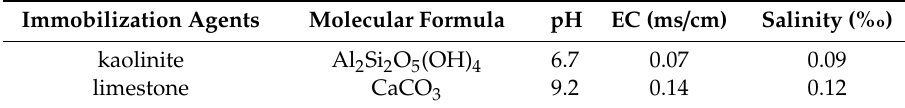
Table 2. The properties of the immobilization amendments.